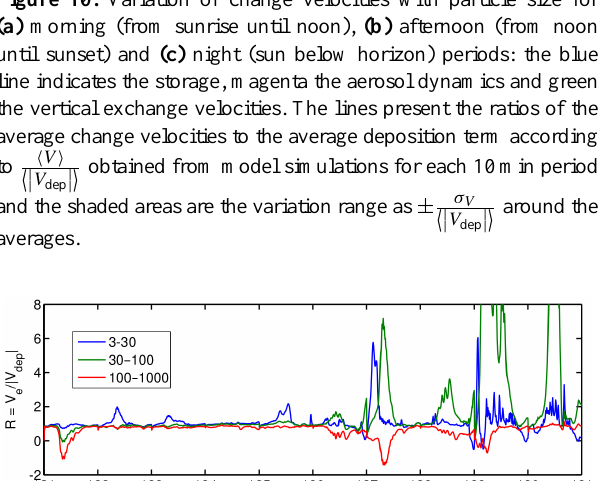
Figure 11. The exchange velocity V e at the canopy top for selected particle size intervals during a 10-day period in May 2013 normal- ized with the absolute value of the deposition velocity | V dep | . Peak values for the size range 30–100nm at DOYs 129 and 130 were about